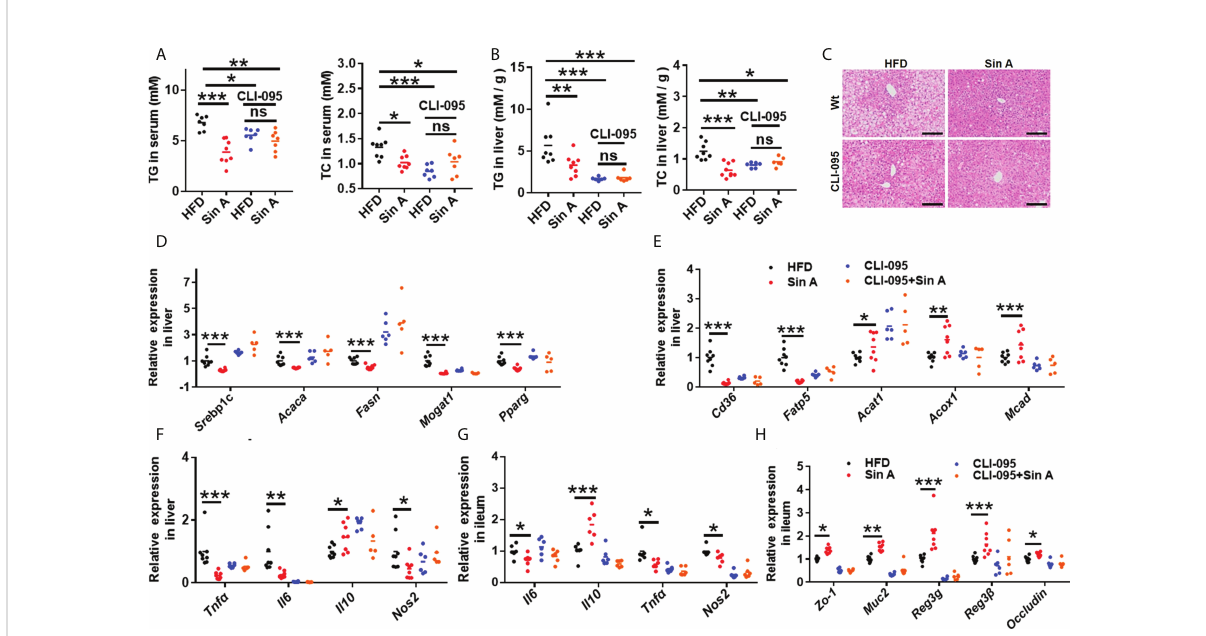
FIGURE 4 LPS-TLR4 signaling is required for the restoration of Sin A in gut in fl ammation and intestinal barrier function in NAFLD mice. Mice were randomly divided into four groups ( n =5 – 8). HFD-fed mice were orally treated with vehicle (HFD), Sin A (80 mg/kg, Sin A), CLI-095 (2 mg/kg, CLI-095), or CLI-095 plus Sin A (CLI-095+ Sin A) for 6 weeks. (A) Changes in TG and TC in serum ( n =7 – 8 per group). (B) Hepatic TG and TC levels ( n =7 – 8 per group). (C) Representative images of H&E staining of liver tissue (Scale bars 50 m m). The key gene expression associated with (D) fatty acids biogenesis and (E) fatty acid uptake and oxidation in liver sections ( n =5 – 8 per group). (F) Changes in hepatic gene expression related to in fl ammation response. Results of gene expression associated with (G) ileum in fl ammation response and (H) tight junction molecules ( n =5 – 8 per group). Values are expressed as means ± SD. Statistical signi fi cance was determined by two-way ANOVA for the multiple-group comparisons. p *<0.05; ** p <0.01; *** p <0. 001. Srebp-1c, sterol regulatory element binding protein-1c; Acaca, acetyl-CoA carboxylases alpha; Fasn, fatty acid synthase; Mogat1, Monoacylglycerol O-altransferase 1; Pparg, peroxisome proliferative activated receptor, gamma; Scd-1, stearoyl-coenzyme A desaturase-1; Cd36, cluster of differentiation 36; Fatp5, fatty acid transport protein 5; Acat1, cholesterol acyltransferase 1; Acox1, acyl-CoA oxidase 1; Mcad, medium-chain acyl-coA dehydrogenase; Tnfa, tumor necrosis factor a ; Il6, interleukin 6; Il10, interleukin10; Nos2, Nitric Oxide Synthase2; Zo-1, zonula occludens-1; Muc2, mucin2; Reg3g, Regenerating islet-derived protein 3 gamma; Reg3 b , Regenerating islet-derived protein 3